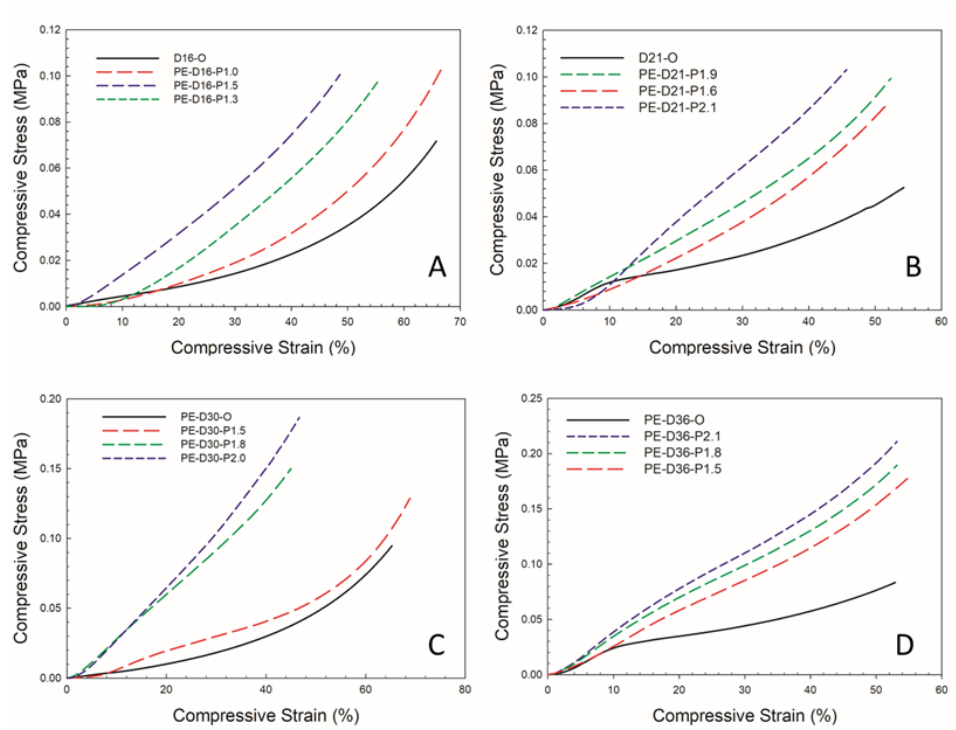
Figure 9. Compressive stress – strain diagrams for the auxetic and original foams based on ( A ) D16, ( B ) D21, ( C ) D30 and ( D ) D36.